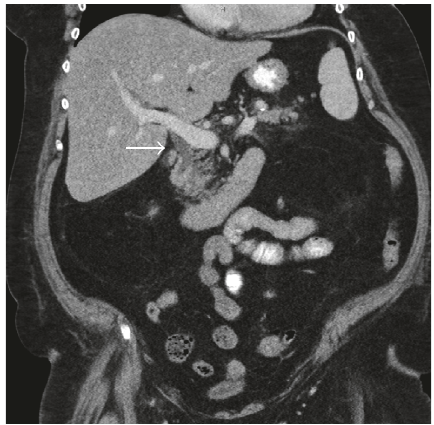
Figure 1: Dilated common bile duct